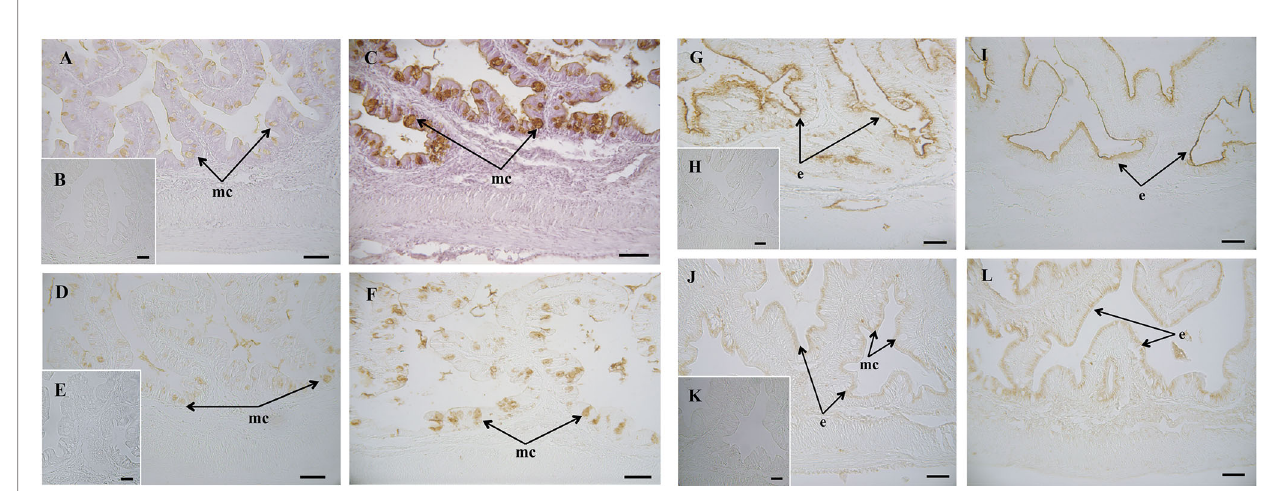
FIGURE 3 | Histochemical localization of glycoconjugates containing sugar residues in the intestine of gilthead seabream ( Sparus aurata ) fed a control or a medicinal plant leaf extract (MPLE)-supplemented diet. Presence of glycoconjugates containing N-acetyl-D-glucosamine and/or N-acetylneuraminic acid residues in mucous cells of S. aurata fed a control (A) ( B : negative control) or a MPLE-supplemented diet (C) . Note the increase in af fi nity for WGA lectin in the mucinous content of goblet cells from MPLE diet. Glycoconjugates containing a -N-acetyl-D-galactosamine residues in mucous cells of S. aurata fed a control (D) ( E : negative control) or a MPLE-supplemented diet (F) . Results denote a moderate increase in af fi nity for the SBA lectin in the mucous cells from MPLE diet. Histochemical detection of glycoconjugates containing N-acetylneuraminic acid/sialic acid residues in the intestine from control (G) ( H : negative control) or MPLE group (I) . Note the decrease in af fi nity for the SNA lectin in the intestinal epithelium of S. aurata fed a MPLE-supplemented diet. Glycoconjugates containing a -mannose/ a -glucose residues in intestine from S. aurata fed a control (J) ( K : negative control) or a MPLE-supplemented diet (L) . Observe the increase in af fi nity for the ConA lectin in the intestinal epithelium of S. aurata fed a MPLE-supplemented diet. Mucous cells were negative for ConA lectin in both control and MPLE groups. e: epithelium; mc: mucous cells. The MPLE included in the basal diet was obtained from sage ( Salvia of fi cinalis ) and lemon verbena ( Lippia citriodora ). Scale bar = 50